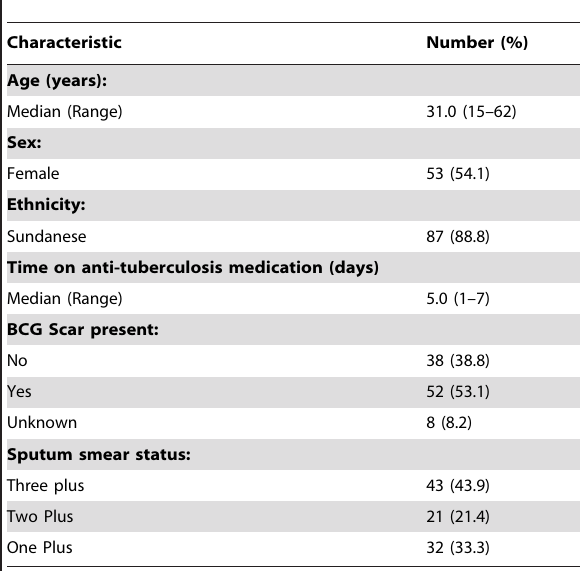
Table 1. Patient characteristics.